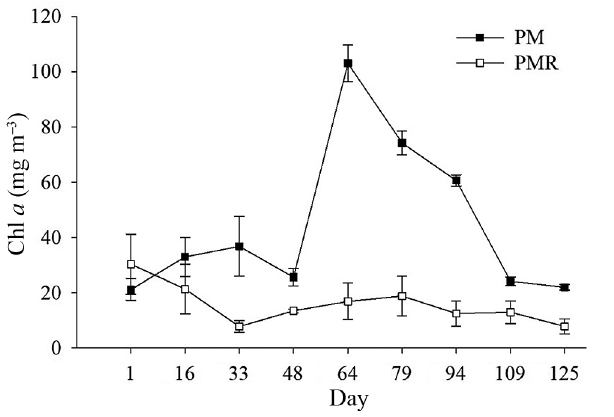
Fig. 3. Variations in chl a concentration in the PM and PMR aquaculture systems (defined in Table 1) during the farming